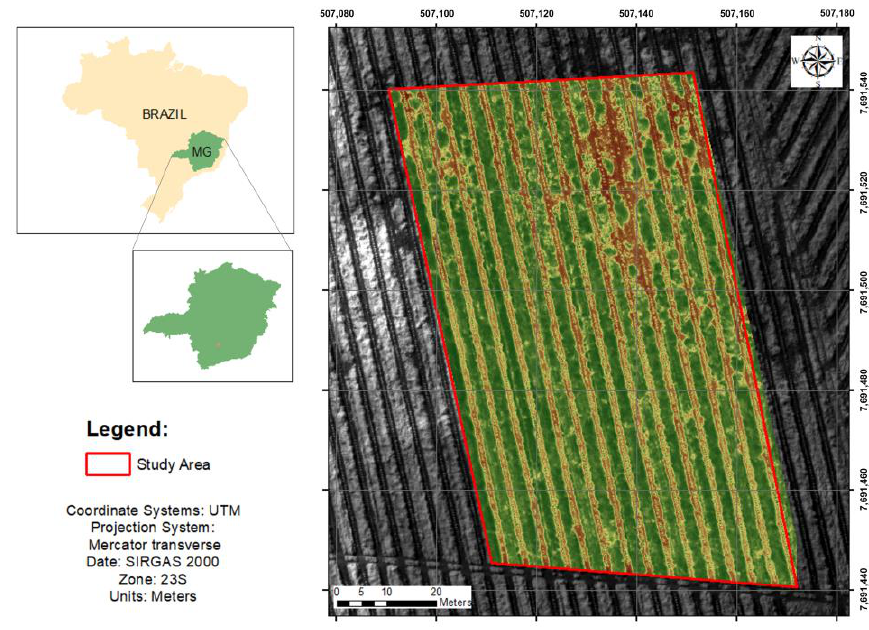
Figure 1. Location of the study area.